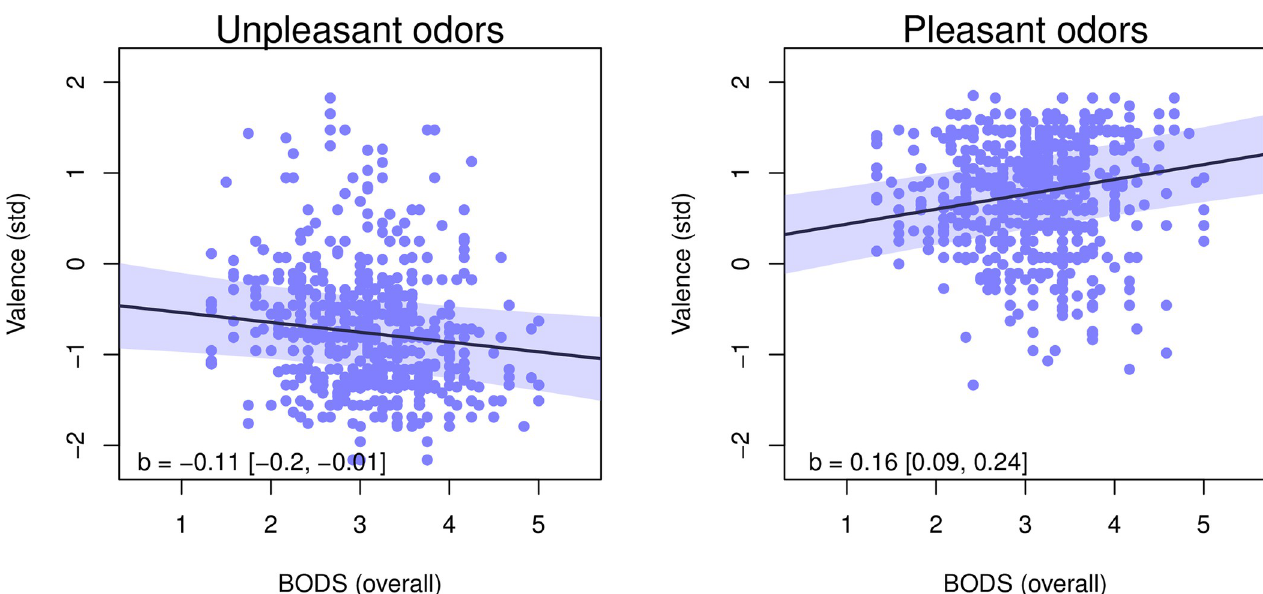
Fig 1. Relationship between overall BODS score and standardized valence ratings for unpleasant (left) and pleasant (right) odors. The shaded area and numbers in square brackets represent 94% HPDI for the slope. https://doi.org/10.1371/journal.pone.0284397.g001 3.1.2. BODS external subscale predicts odor valence best. Three models had similar